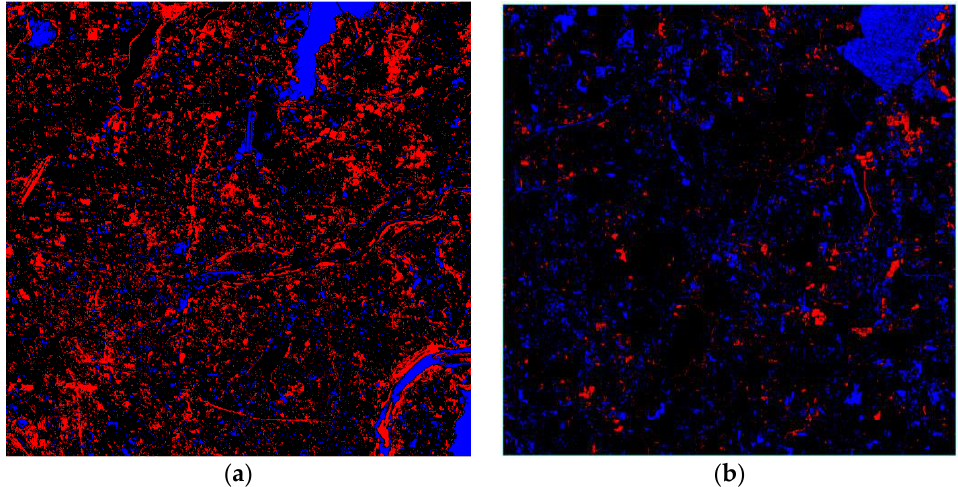
Figure 14. Pixel-based change detection results for ( a ) GF-1 and ( b ) Landsat images.